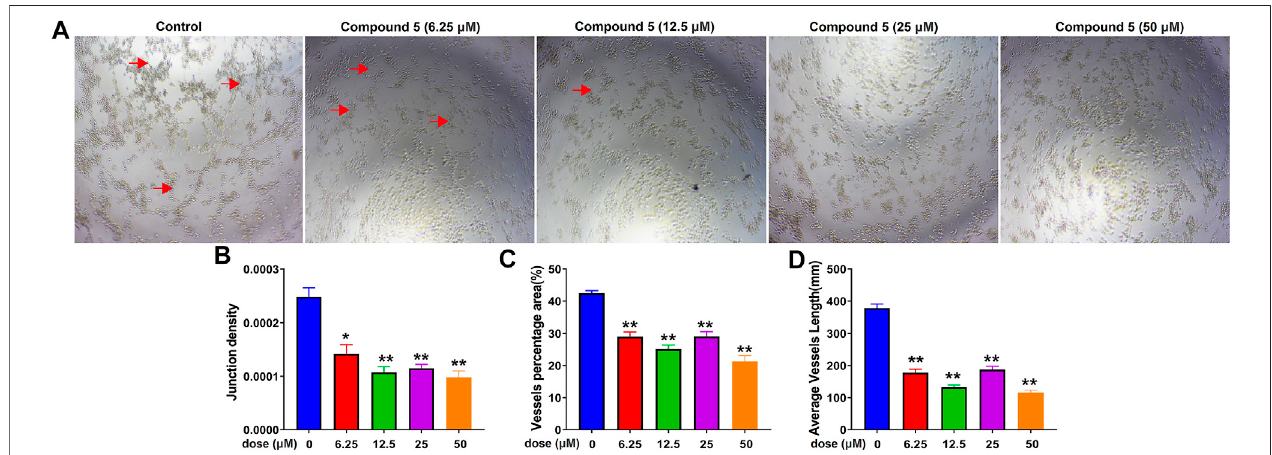
FIGURE10| Theinhibitoryeffectofcompound 5 onangiogenesis. (A) Bright fi eldimagesofHUVECsseededonMatrigelfor24 haftertreatmentatdifferentdoses of compound 5 ; red arrows indicated the cavities formation during angiogenesis. (B) , (C) , (D) Quantitative analysis on junction densities, vessel percentage areas, and average vessel lengths, respectively. Data are expressed as mean ± SD of three independent experiments. * p < 0.05, ** p < 0.005, *** p < 0.001 compared with the control